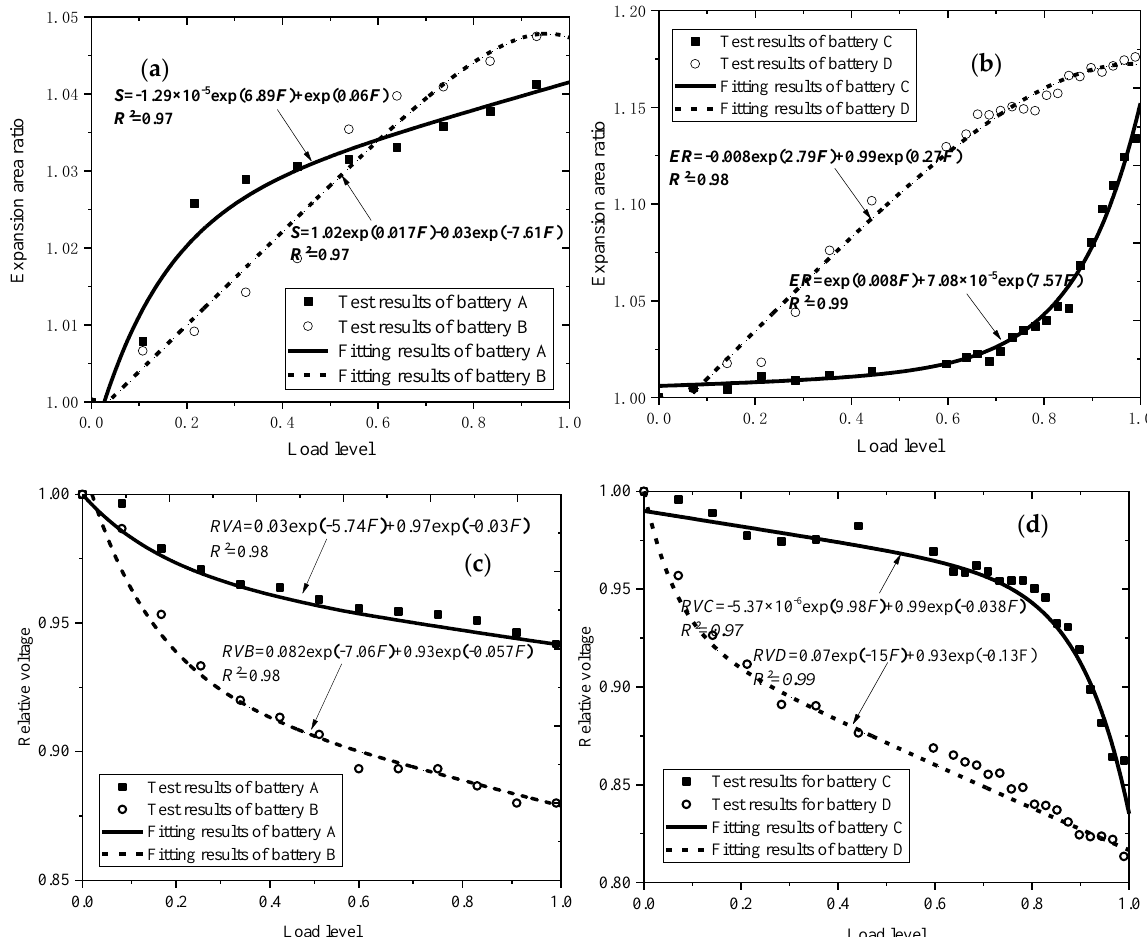
Figure 9. Relationship between expansion area ratio and relative voltage of thin-film cells and load level: ( a , b ) are expansion area ratio; ( c , d ) are relative